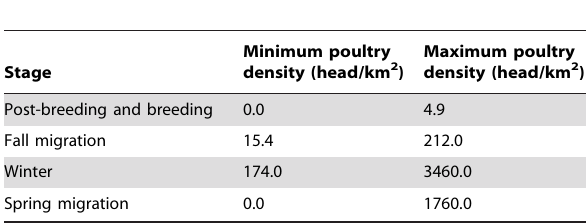
Table 4. Mean weekly exposure of whooper swans to poultry by annual cycle stage.